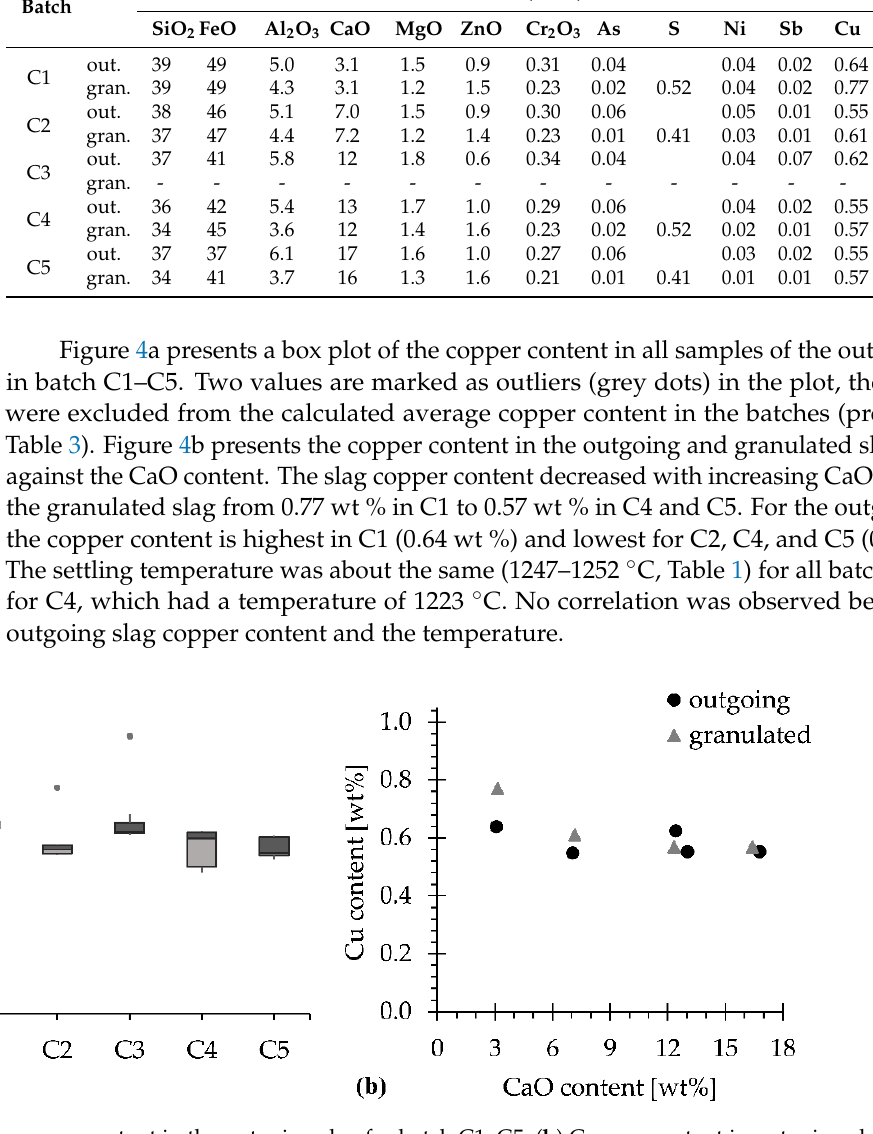
Table 3 presents the composition of the (average) outgoing slag and the granulated slag. The Fe/SiO 2 ratio (wt %/wt %) was based on the compositions of the granulated slag (from Table 3) and varied from 0.79–0.97, highest in C1 and lowest in C5. The average CaO content in the outgoing slag increased from 3.1 wt % in C1 to 17 wt % in C5. The CaO content of the outgoing slag differs from that of the ingoing slag, which was ascribed to a dilution effect when the slag remaining from the previous batch was mixed with new slag and tapped into the settling furnace. Table 3. Normalized compositions of average outgoing (out.) slag and the granulated slag (gran.), and the standard deviation of copper. The sample of the granulated slag was missing for C3. The sulfur content was only analyzed for the granulated slag (FAAS method). out. (wt %) Batch